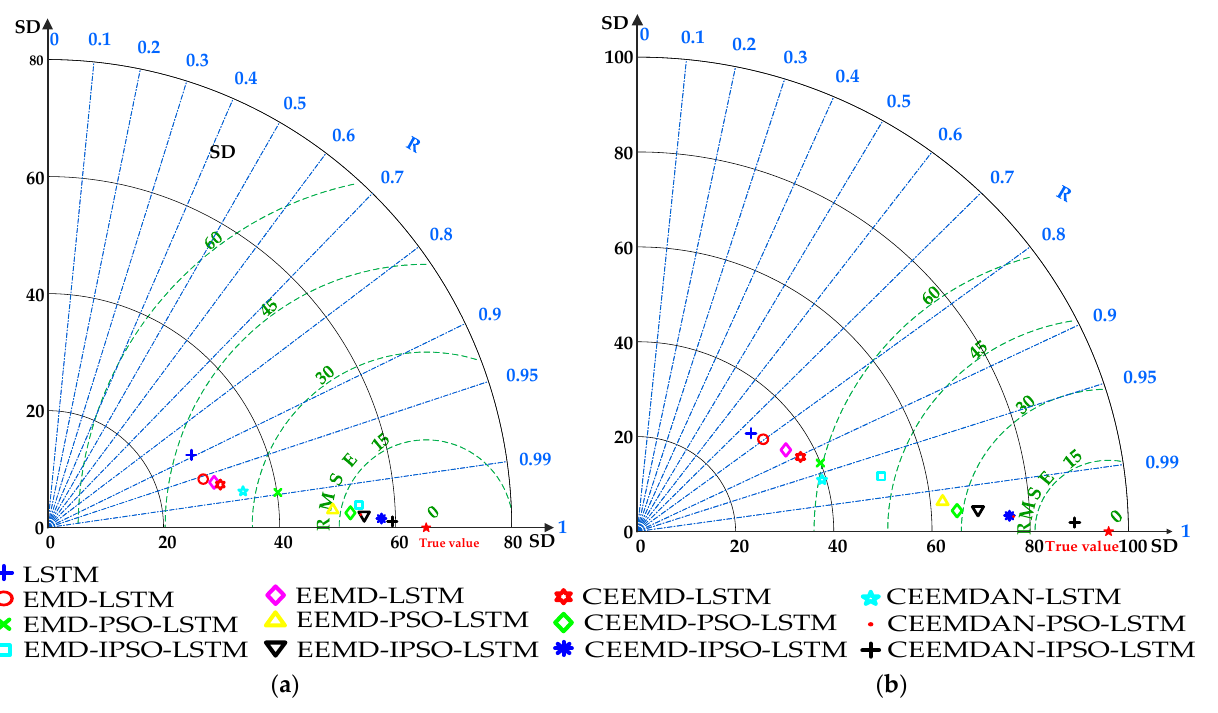
Figure 8. Taylor diagram of 13 prediction models. ( a ) represents the inbound passenger flow, ( b ) represents the outbound passenger flow.